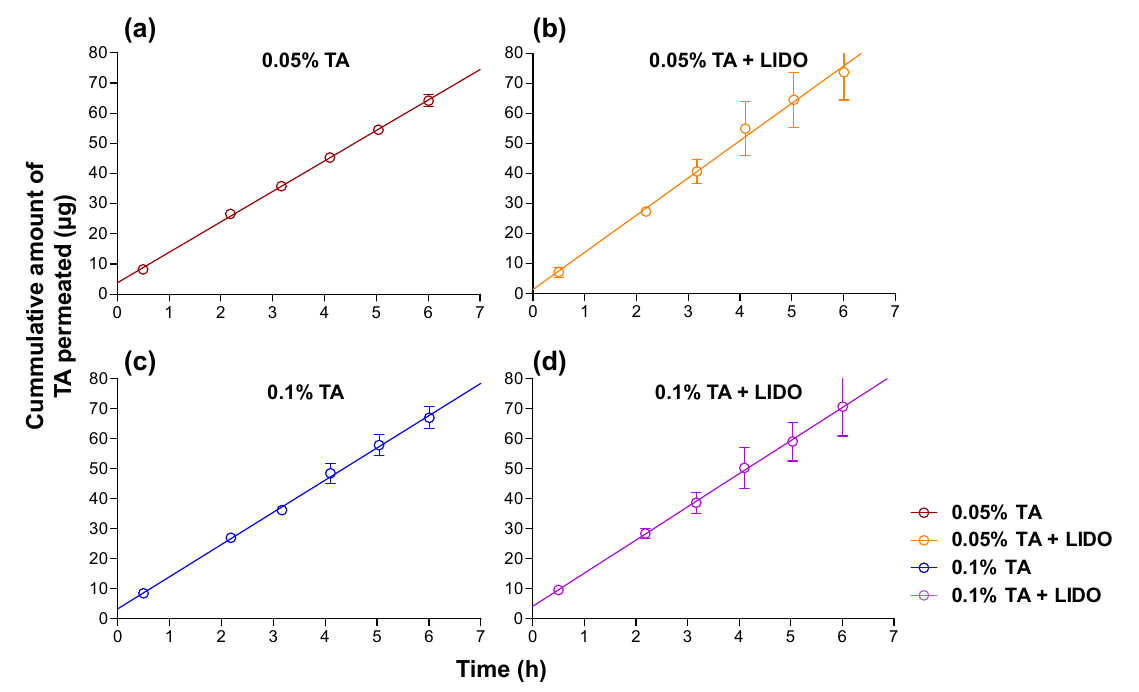
Figure 8. Sublingual permeation kinetics of TA for the different formulations: ( a ) 0.05% TA, ( b ) 0.05% TA + LIDO, ( c ) 0.1% TA, ( d ) 0.1% TA +LIDO. Values represent Means ± SD ( n = 5).